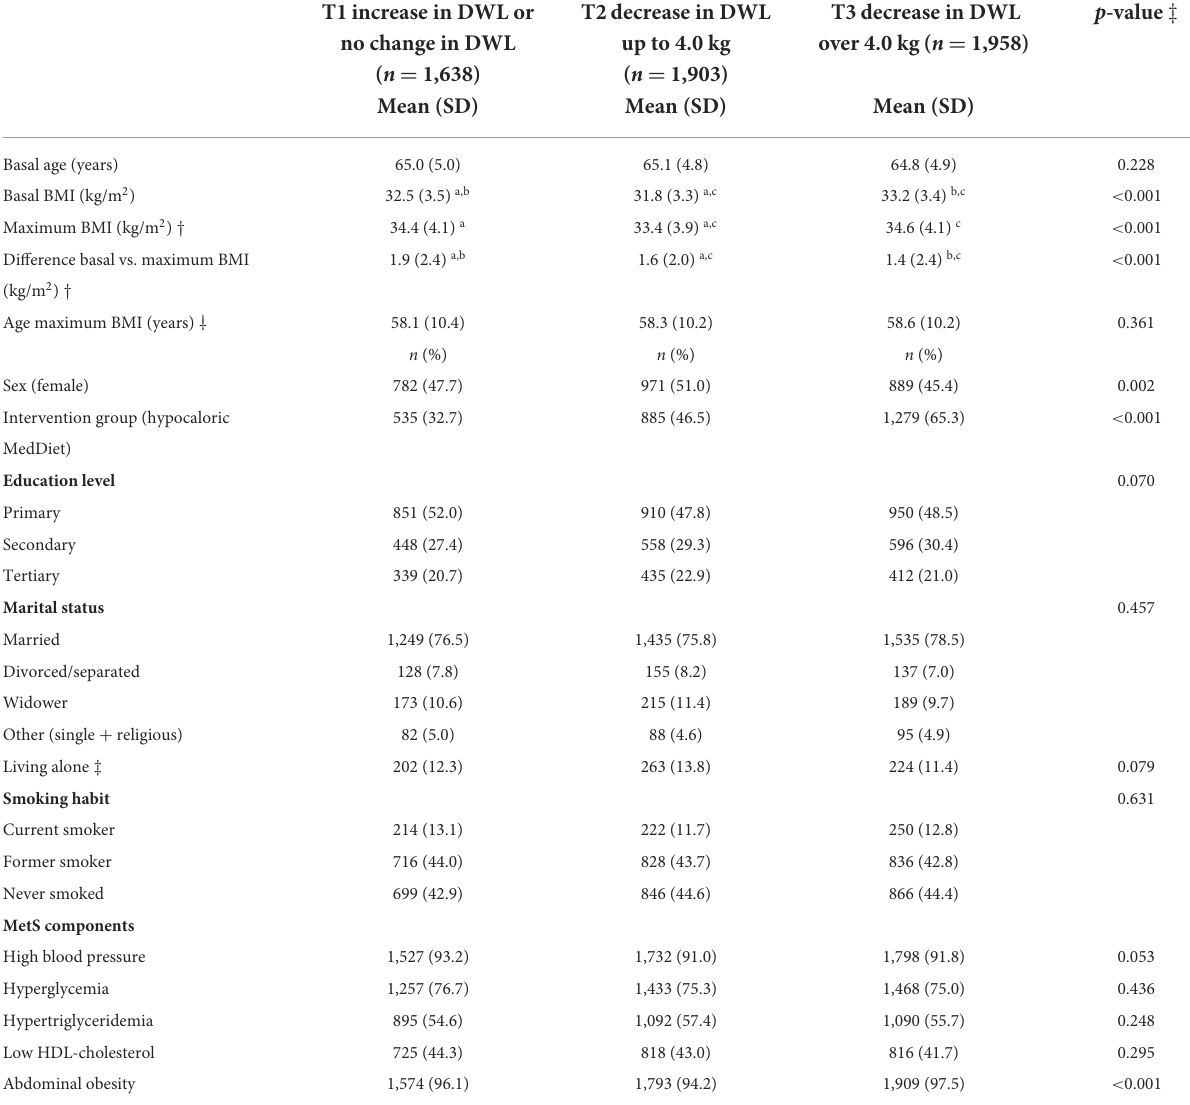
TABLE 1 Baseline sociodemographic and clinical characteristics according to tertiles of change of desired weight loss